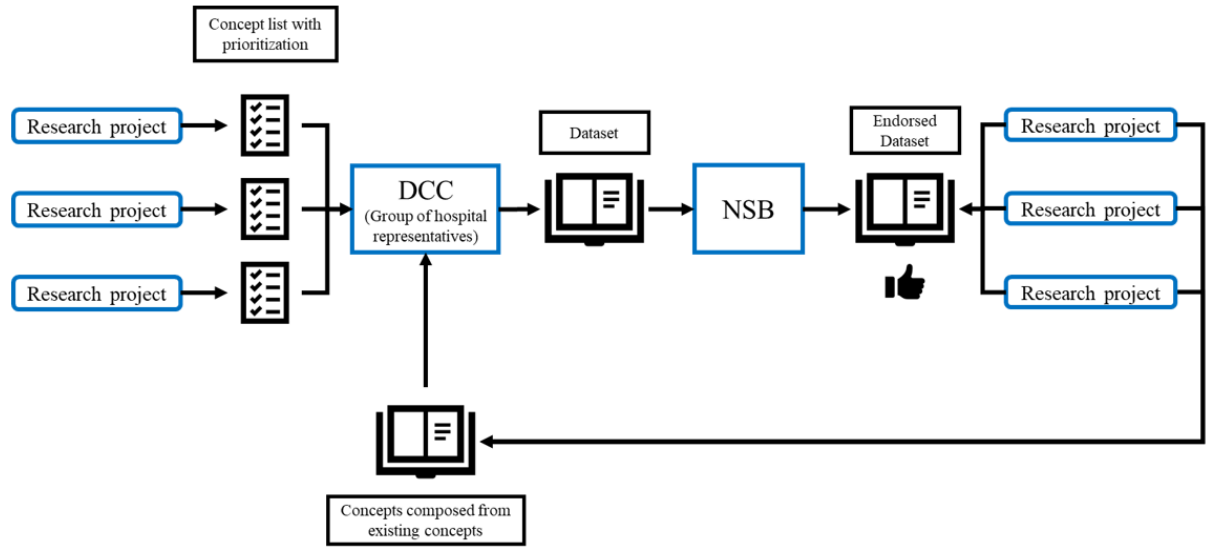
Figure 2. Flowchart of the validation process. DCC: Data Coordination Center; NSB: National Steering Board.